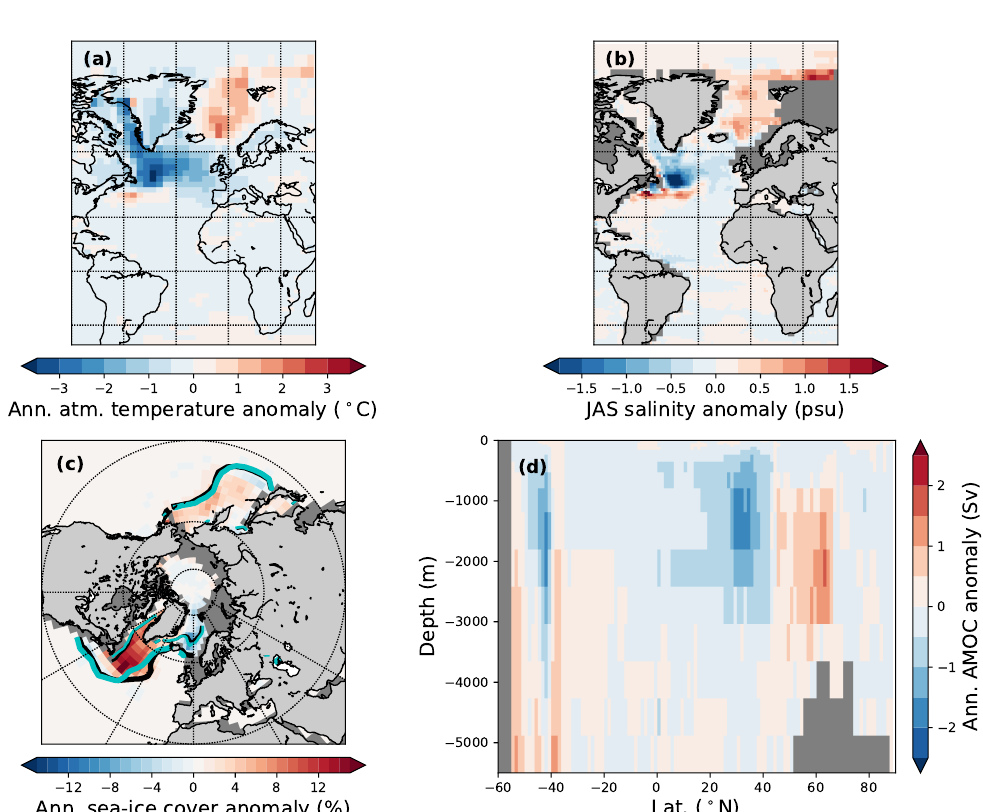
Figure 11. Same as Fig. 10 for the HadCM3 nohose model pool. Note the different limits on the colors compared to Fig. 10.